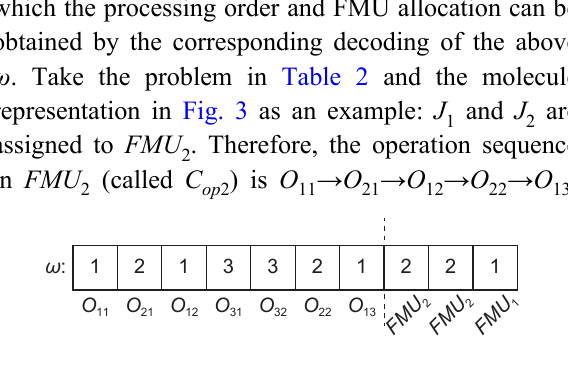
Fig. 3 Molecule representation. Fig. 2 Three encoding methods of